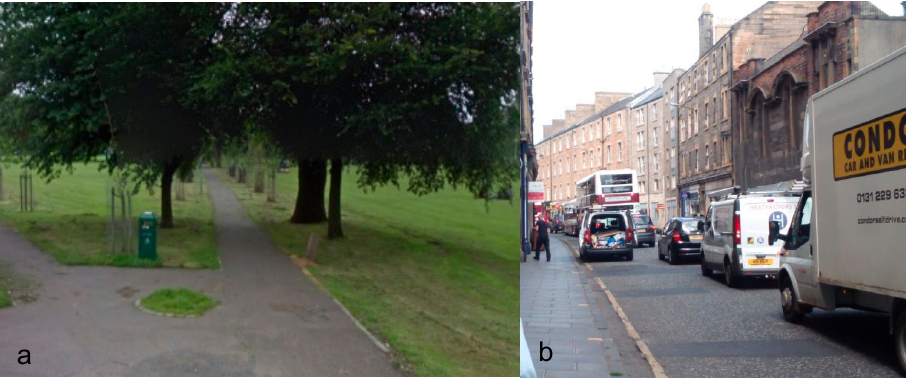
Figure 3. Street views of the two walking environments; ( a ) urban green and ( b ) urban busy (photo credit: OPENspace Research Centre).